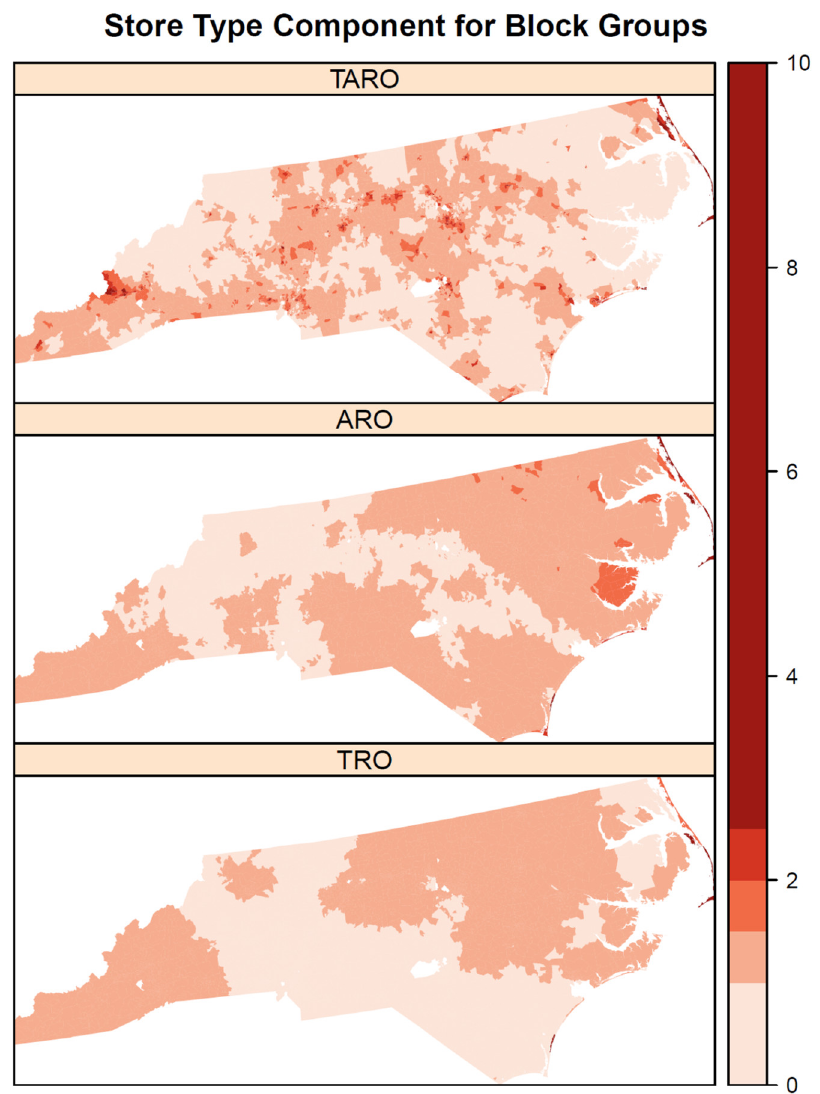
Figure 7. Outlet (TRO, ARO, and TARO) specific spatial component for block groups.